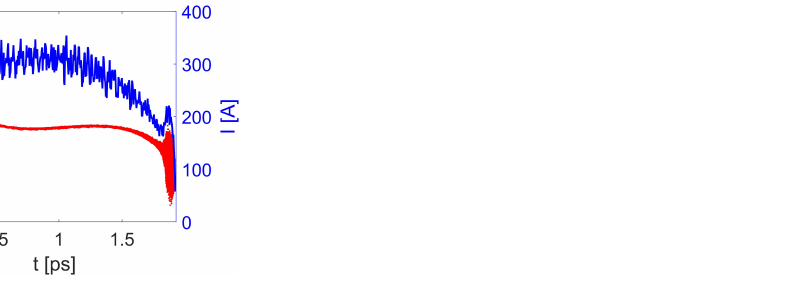
Figure 4. The longitudinal phase space ( γ red line) and the current profile ( I blue line) of the electron